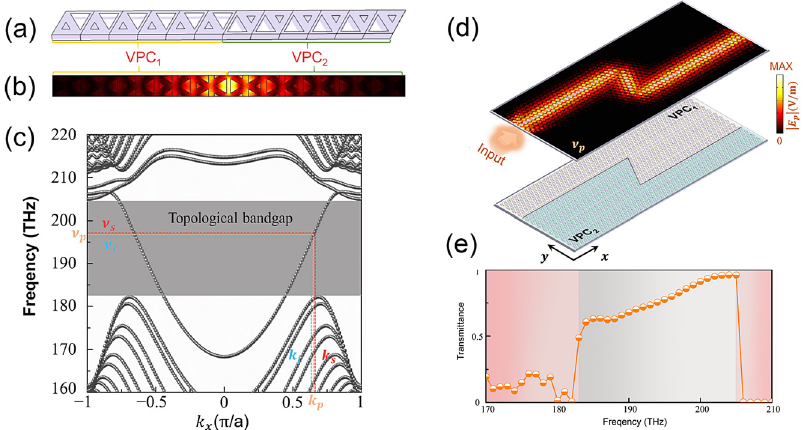
Figure 2: Topological valley kink states in photonic crystals emulating QVH effect. (a) Schema of VPC structure comprising of VPC 1 and VPC 2 . (b) Simulated fi eld pro fi les of the valley kink state around the interface. (c) Calculated band diagram of valley kink states for VPC con fi guration, the gray region denotes the topological bandgap. (d) Field pro fi les of valley kink states along a “ Z ” shaped interface between the VPC 1 and VPC 2 . (e) Linear transmittances of kink states, the light gray and pink regions represent the bandgap and bulk